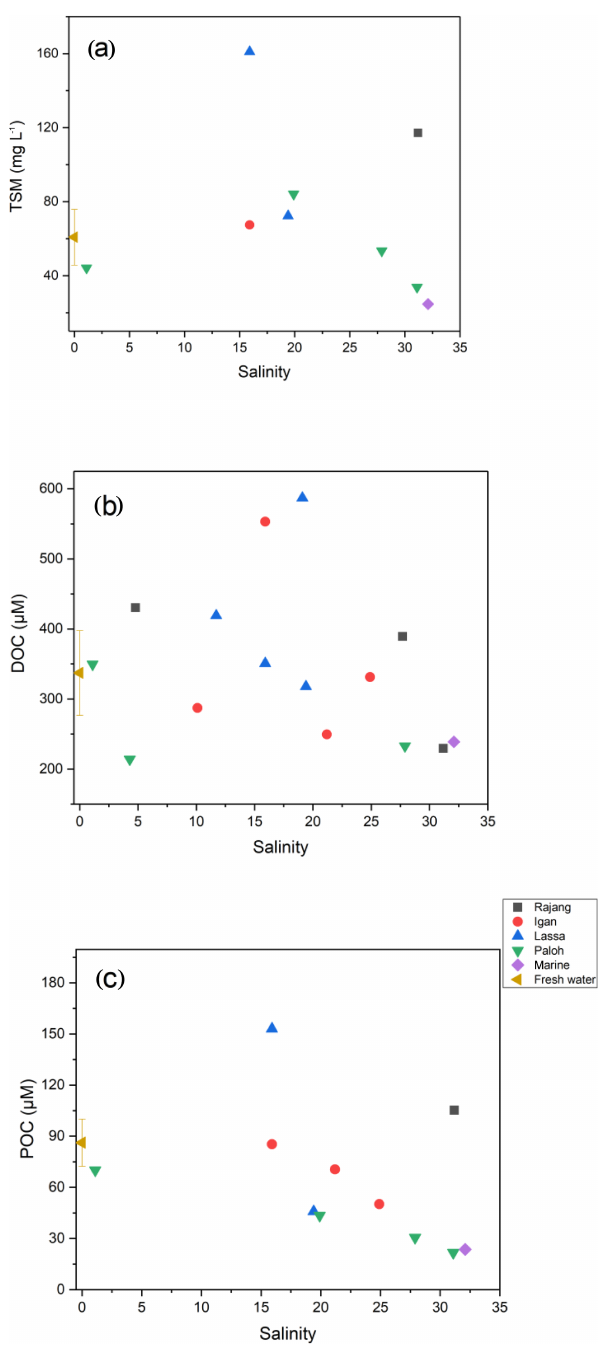
Figure 2. Distribution patterns of (a) TSM, (b) DOC, and (c) POC along with salinity in the Rajang. The freshwater data point repre- sents all samples with a salinity of 0, and the error bar corresponds to the standard deviation. The marine data point represents S1.